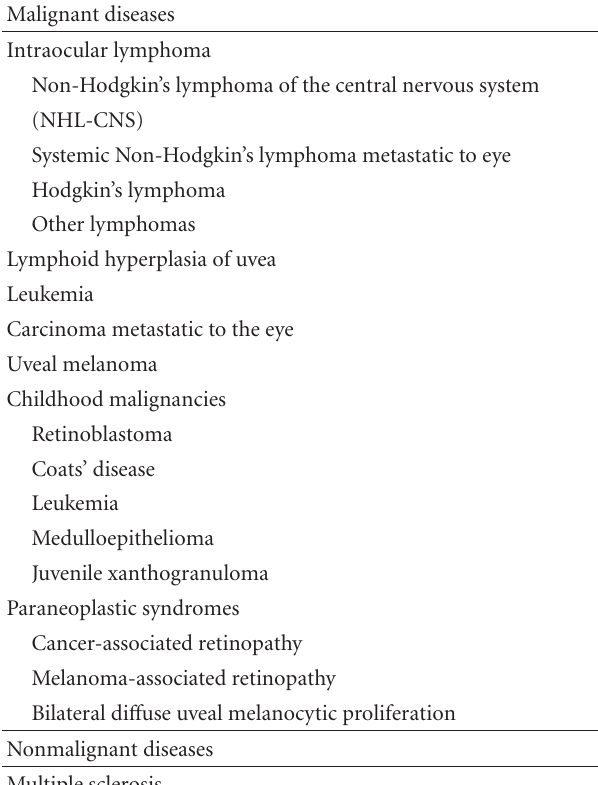
Table 1: Ophthalmic diseases masquerading as chronic idiopathic